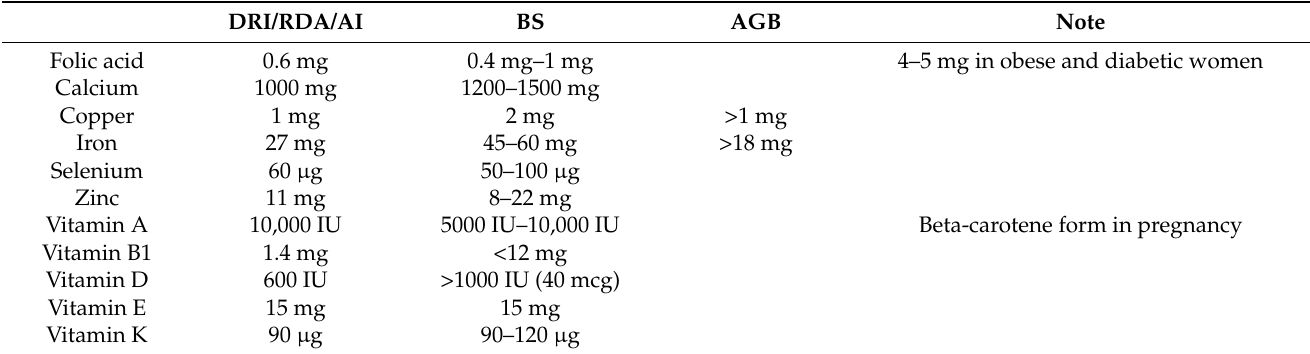
Table 1. Recommended intake of micronutrients and vitamins in physiological pregnancy and in pregnancy after bariatric